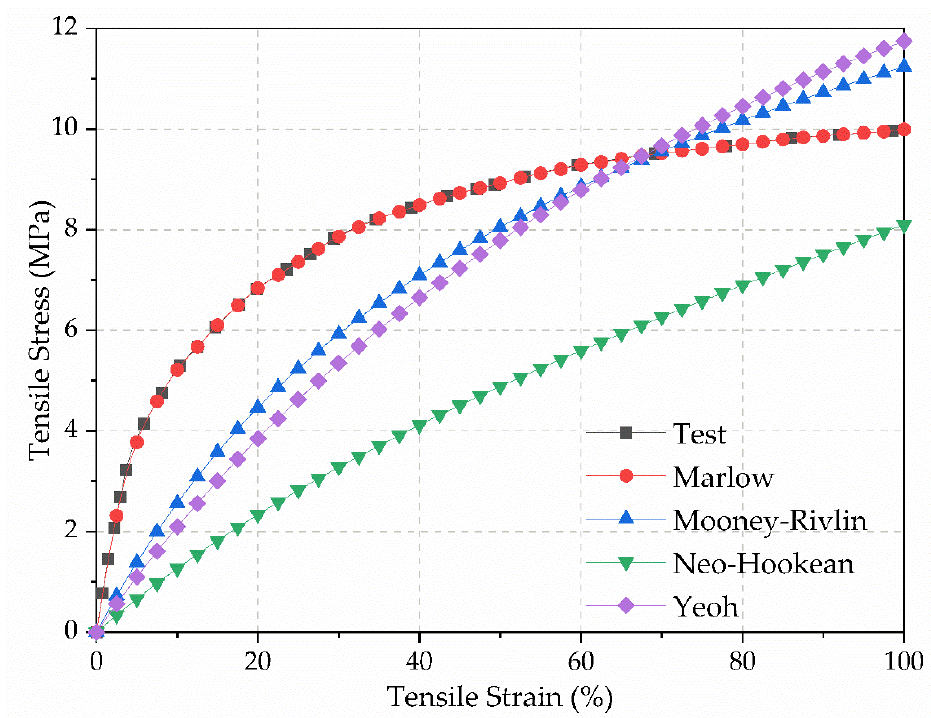
Figure 3. Comparison of the tensile nominal stress–nominal strain curves of the PU material.